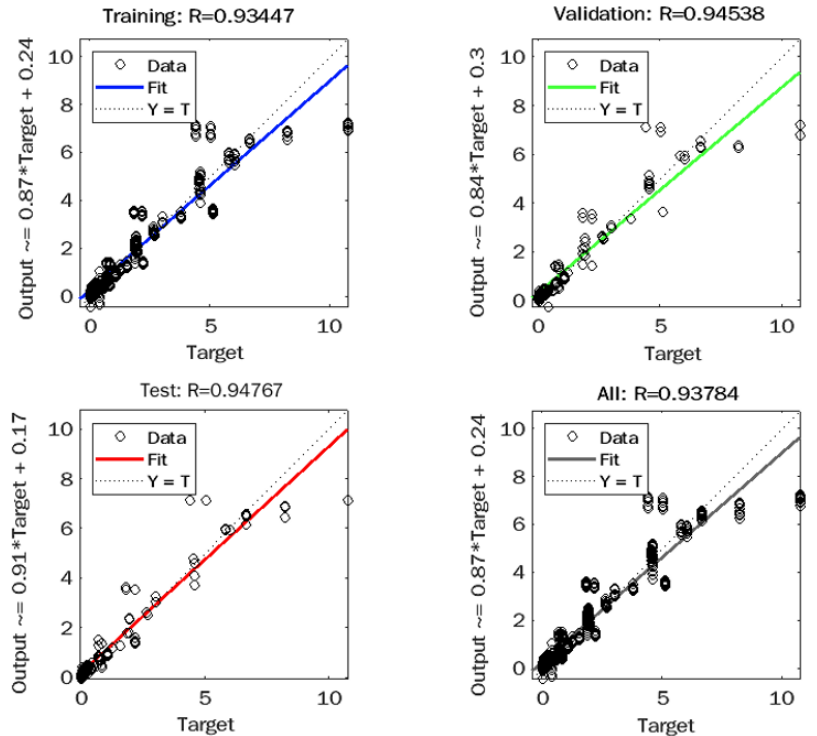
Figure 11. Observed versus predicted plot for J nr 3.2 of unaged